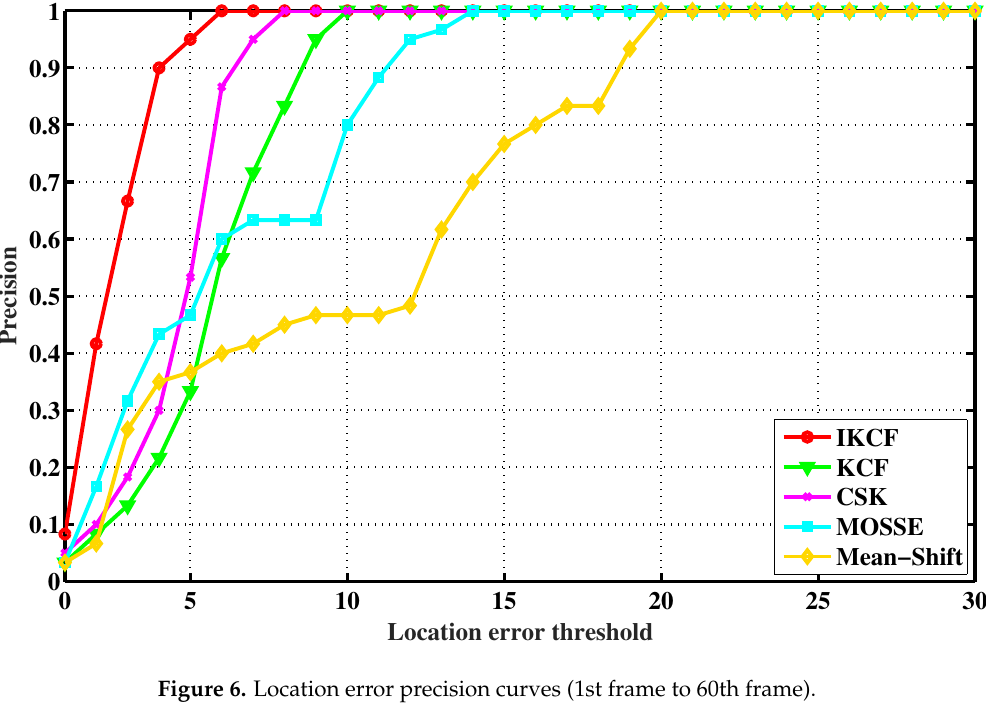
Figure 6. Location error precision curves (1st frame to 60th frame).